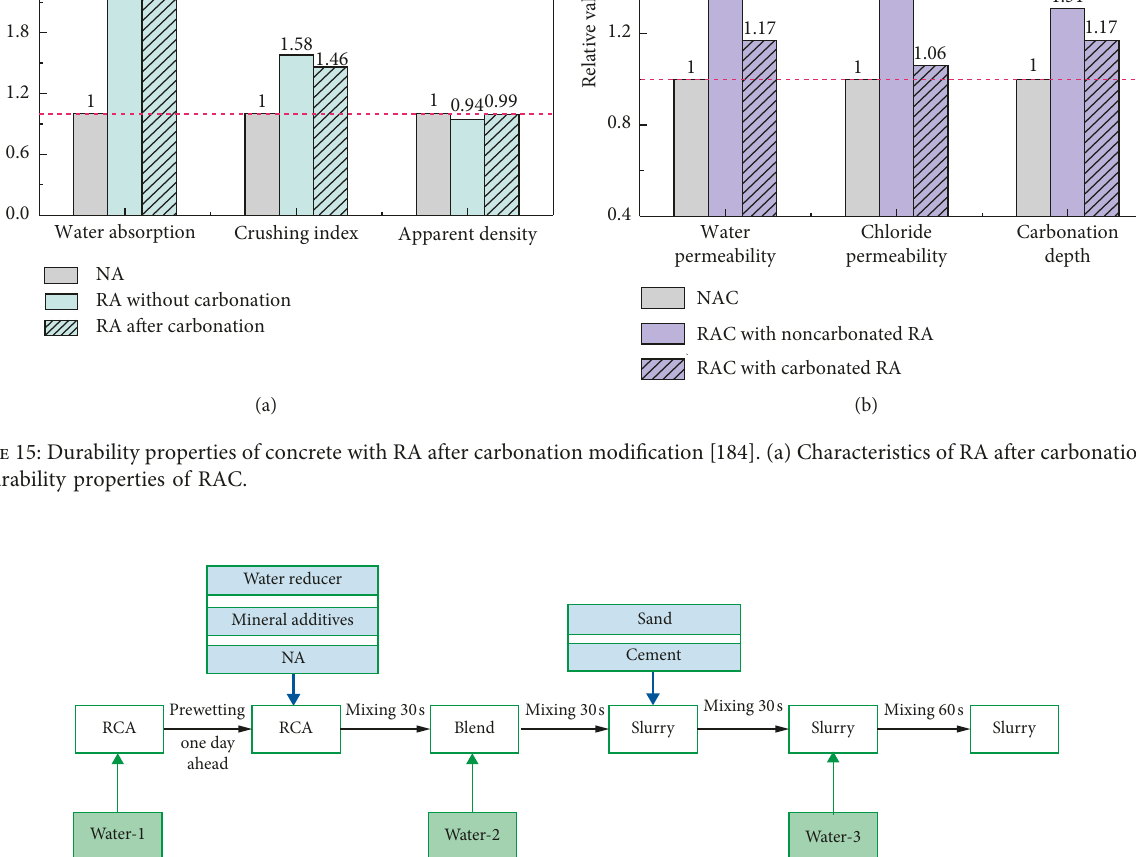
Figure 16: Preparing high-durability RAC by the mixing method of “W3T4”